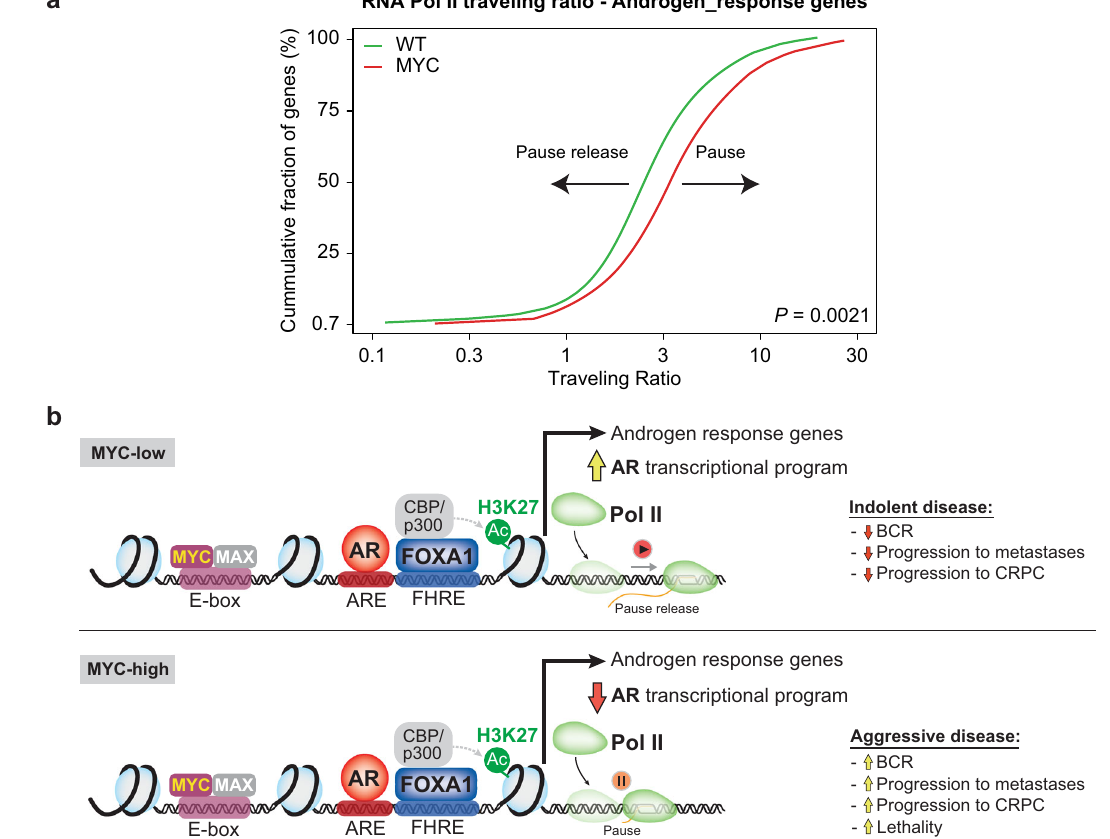
Fig. 8 MYC disrupts transcriptional pause release at androgen receptor targets. a RNA Pol II traveling ratio reveals greater promoter-proximal pausing at Androgen_response genes (two-tailed t -test). b Graphical summary. TSS: transcription start site; TES: transcription end site; BCR: biochemical recurrence; CRPC: castration resistant prostate cancer; FHRE: forkhead response elements; ARE: androgen response